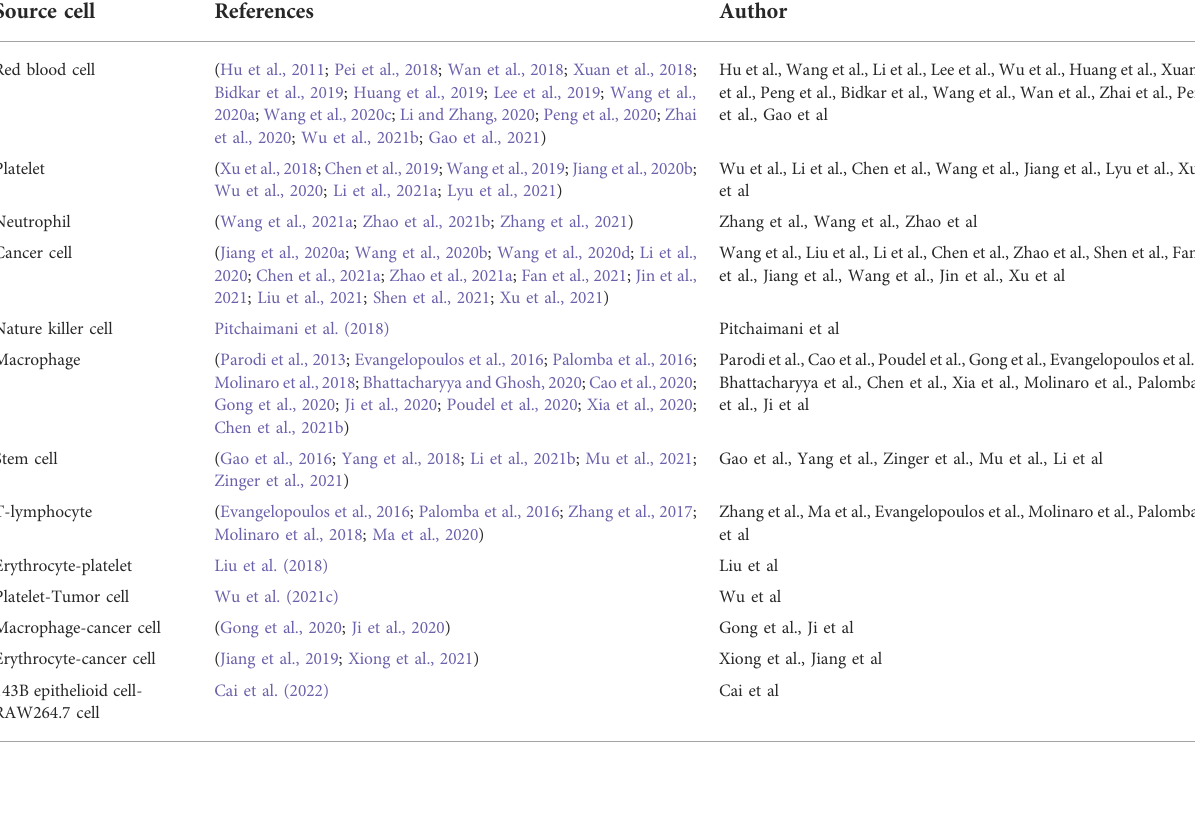
TABLE 1 Summary of different source cells for membrane camou fl aged nanoparticles.